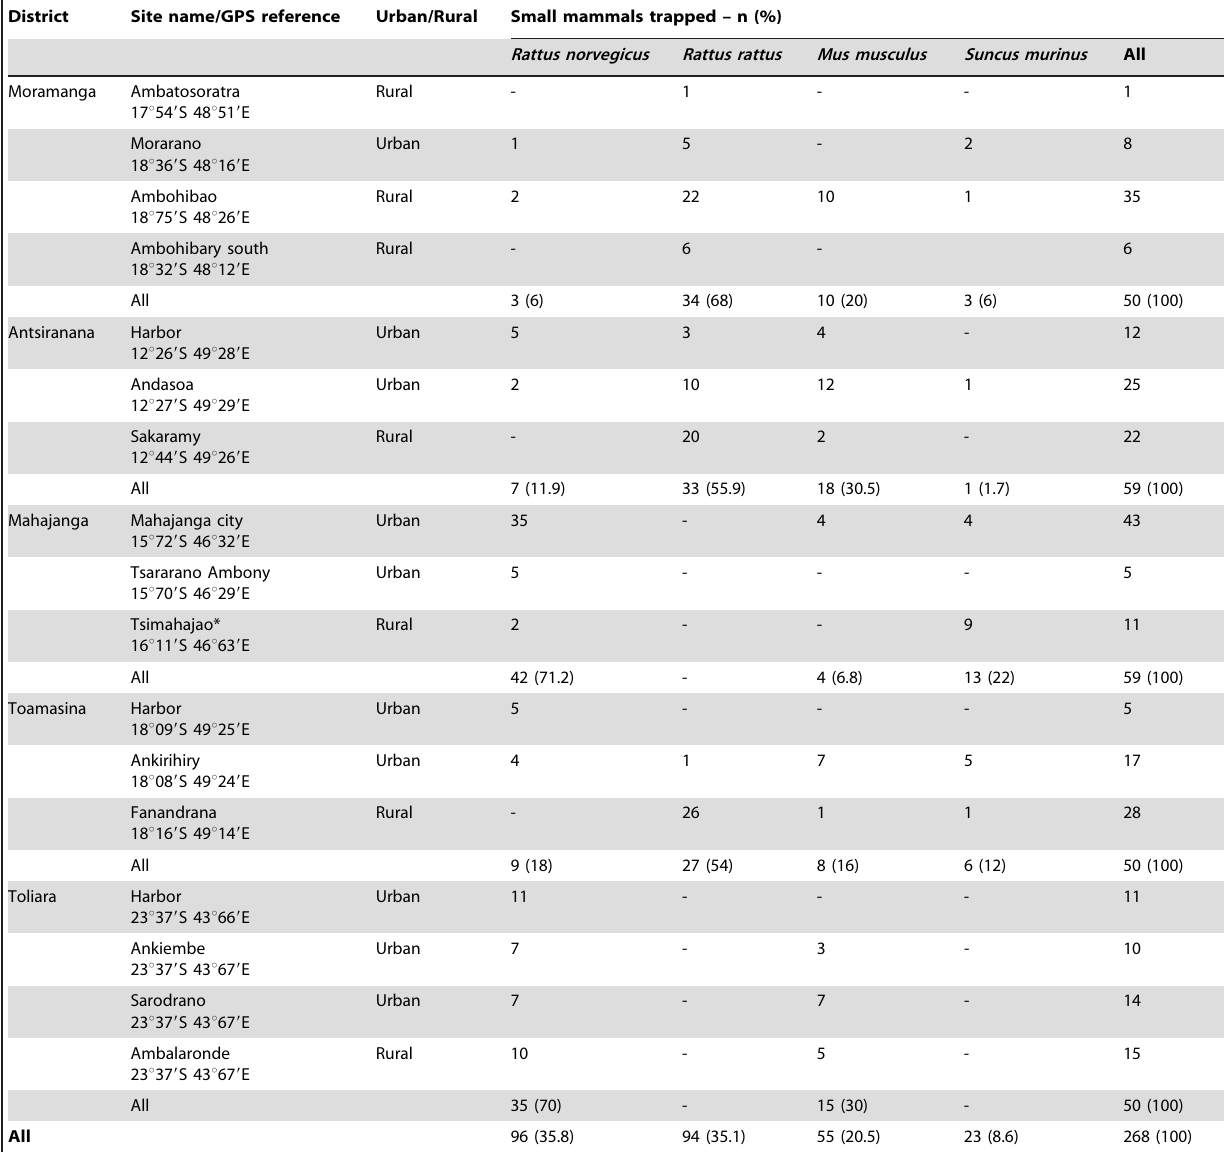
District Site name/GPS